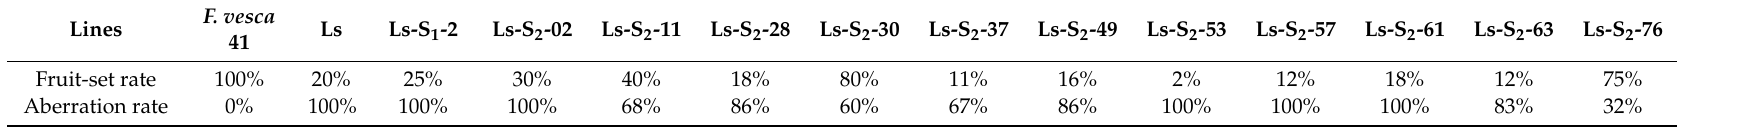
Table 1. Fruit-set rate of Fragaria viridis and self-cross accessions.